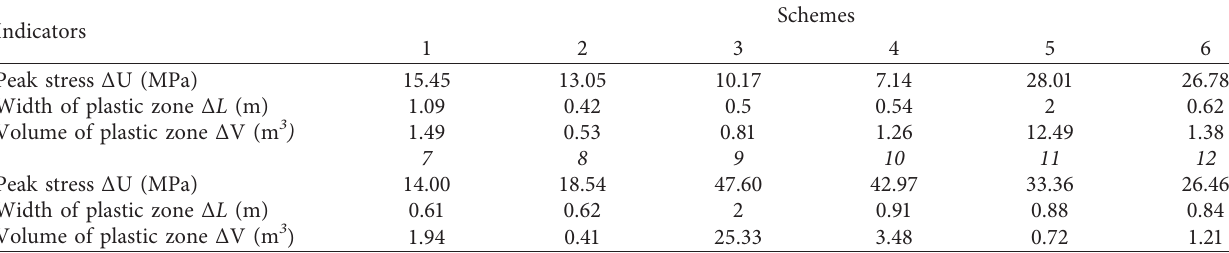
Table 7: Orthogonal test data.